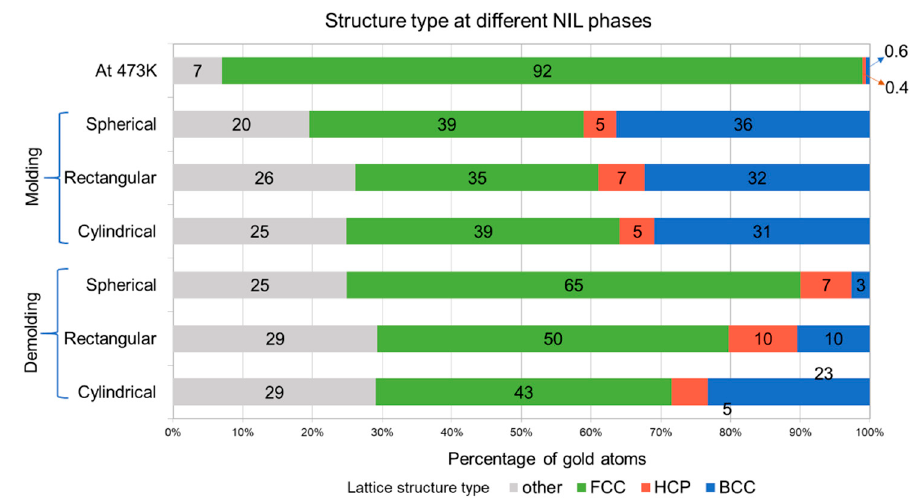
Figure 4. Lattice deformation of gold substrate with different mold profiles. Time steps for each phase are: Raise temp to 473 K—50,000; Molding—78,000; Demolding—160,000.